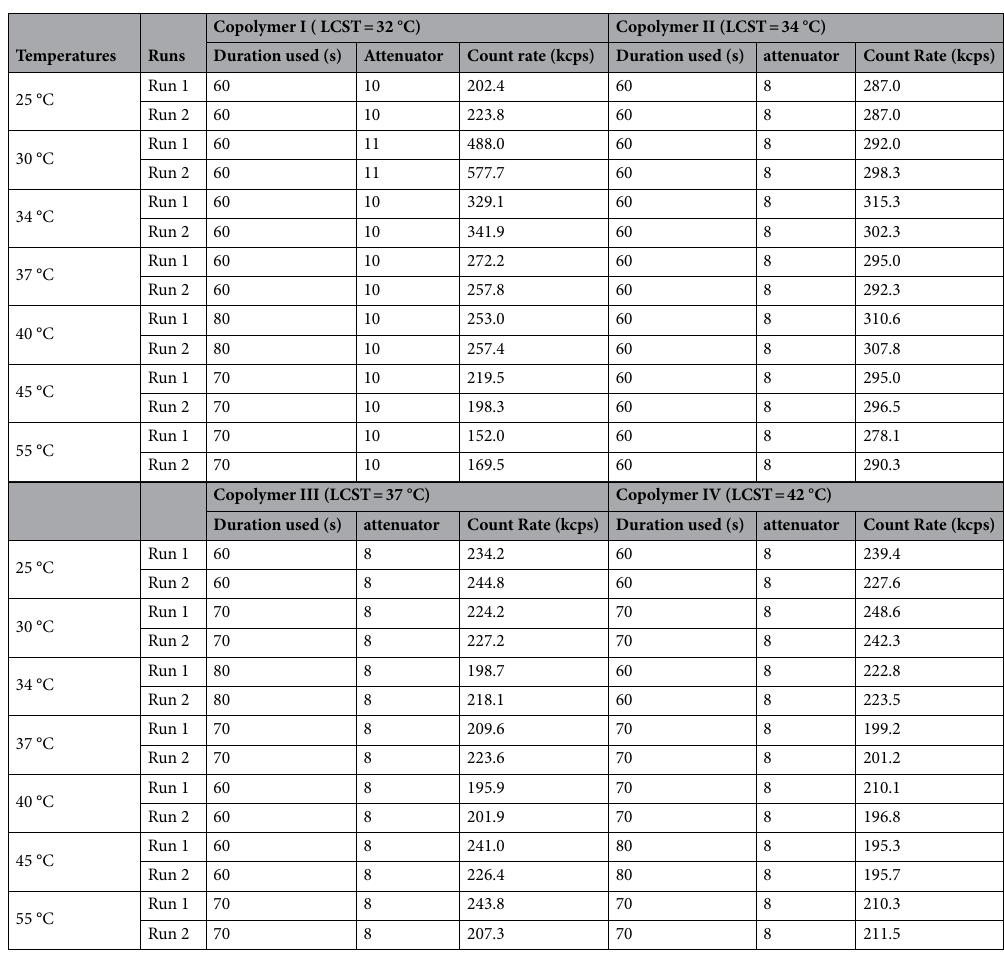
Table 2. samples details related to LCST behavior investigation under seven defined points of temperatures.